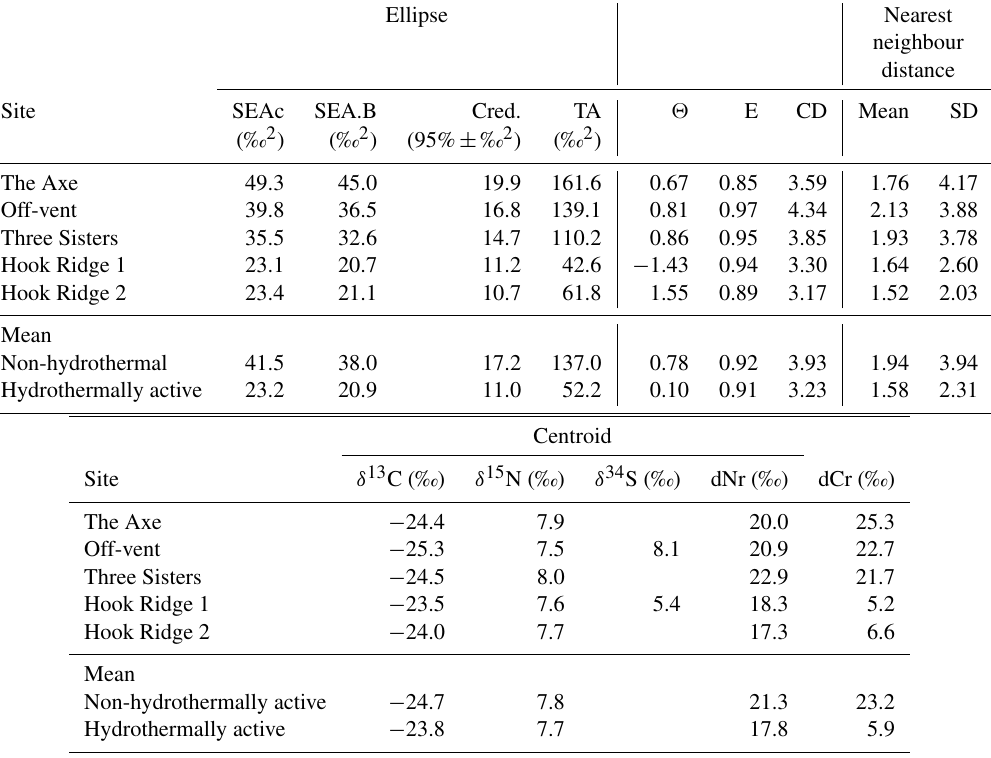
Table 6. Ellipse area and Layman metrics of benthos by site. SEAc: sample-size-corrected standard elliptical area; SEA.B: Bayesian estimate of standard elliptical area; TA: total hull area; E: eccentricity; dNr: nitrogen range; dCr: carbon range; dSr: sulfur range; CD: centroid distance. Ellipse Nearest